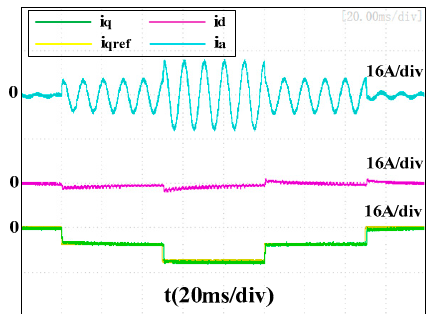
Figure 14. d-q axis current waveform of the conventional current controller without decoupling at 6000 rpm with Kp = 1000 π Ls.